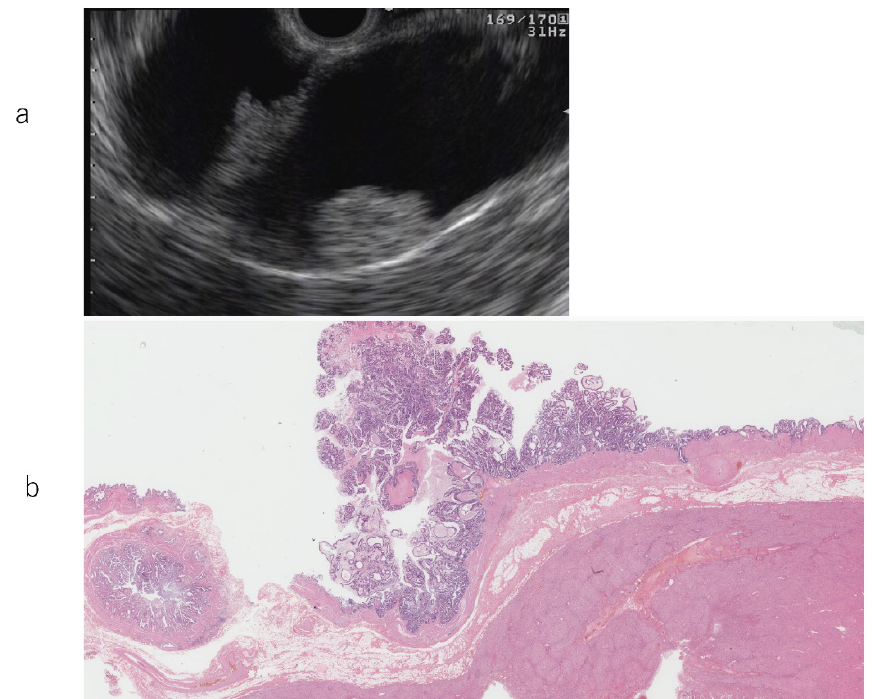
Figure 1. Early-stage gallbladder cancer (m) type I. ( a ) Endoscopic ultrasonography: Broad-based elevated lesion in the gallbladder body. Nodular surface structure and slightly non-uniform internal echo. Regular hyperechoic external layer of the gallbladder wall where the lesion is attached. ( b ) Magnified image: Papillary-shaped tumor. Low papillary-shaped lesion contiguous with the base of the papillary-shaped lesion. No invasion of the proper muscular layer.